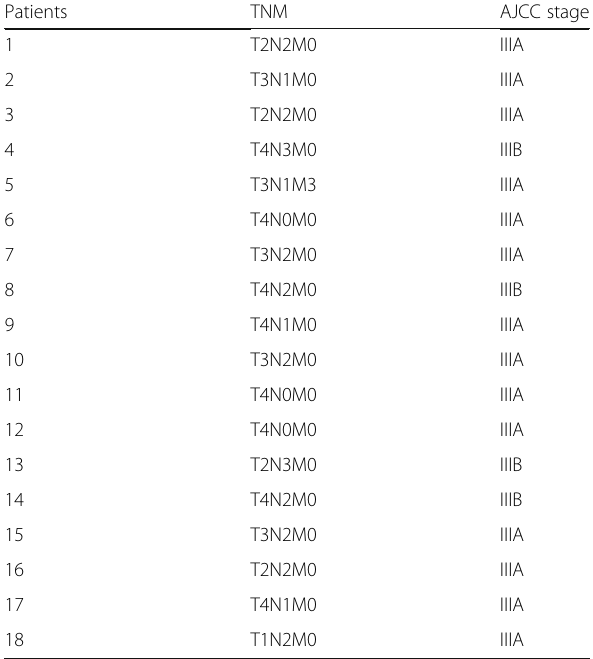
Table 2 TNM stages and AJCC anatomic stage